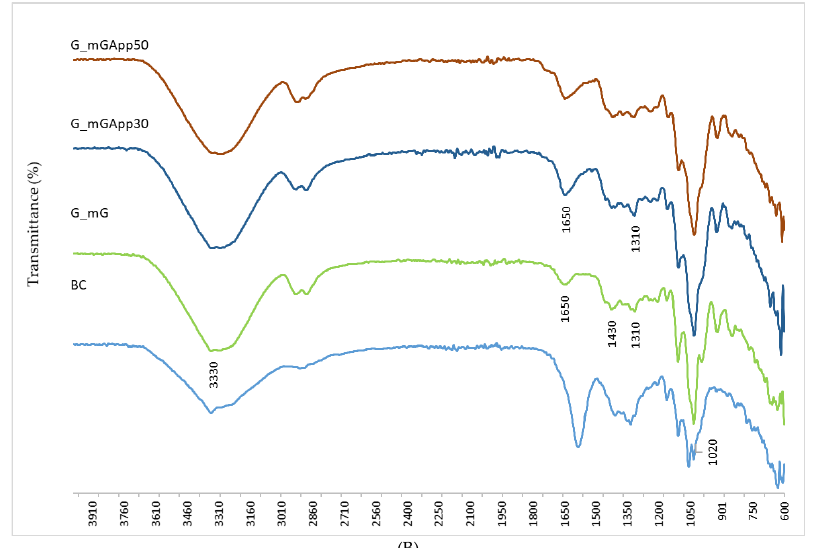
Figure 3. FTIR spectra of bacterial cellulose and the modified materials. The FTIR spectra of bacterial cellulose (BC) are compared with mG (BC pre-treated and modified with glycerol) and mGApp50 (BC pre-treated then modified with glycerol and AP at a concentration of 50%) in ( A ), whereas the spectra of BC grown in the media with AP (G_mG — BC produced in the media with AP, pre-treated and modified with glycerol; G_mGApp30 and G_mGApp50 — BC produced in the media with AP, pre-treated followed by modification with glycerol and AP at concentrations indicated by the number) are compared in ( B ).